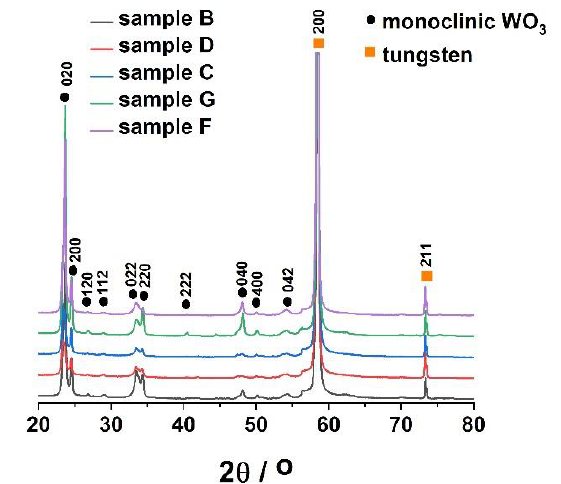
Figure 5. X-ray diffraction ( XRD) patterns of WO 3 layers obtained in various anodizing conditions Figure 5. X-ray di ff raction (XRD) patterns of WO 3 layers obtained in various anodizing conditions and and annealed in air at 500 °C for 2 h. annealed in air at 500 ◦ C for 2